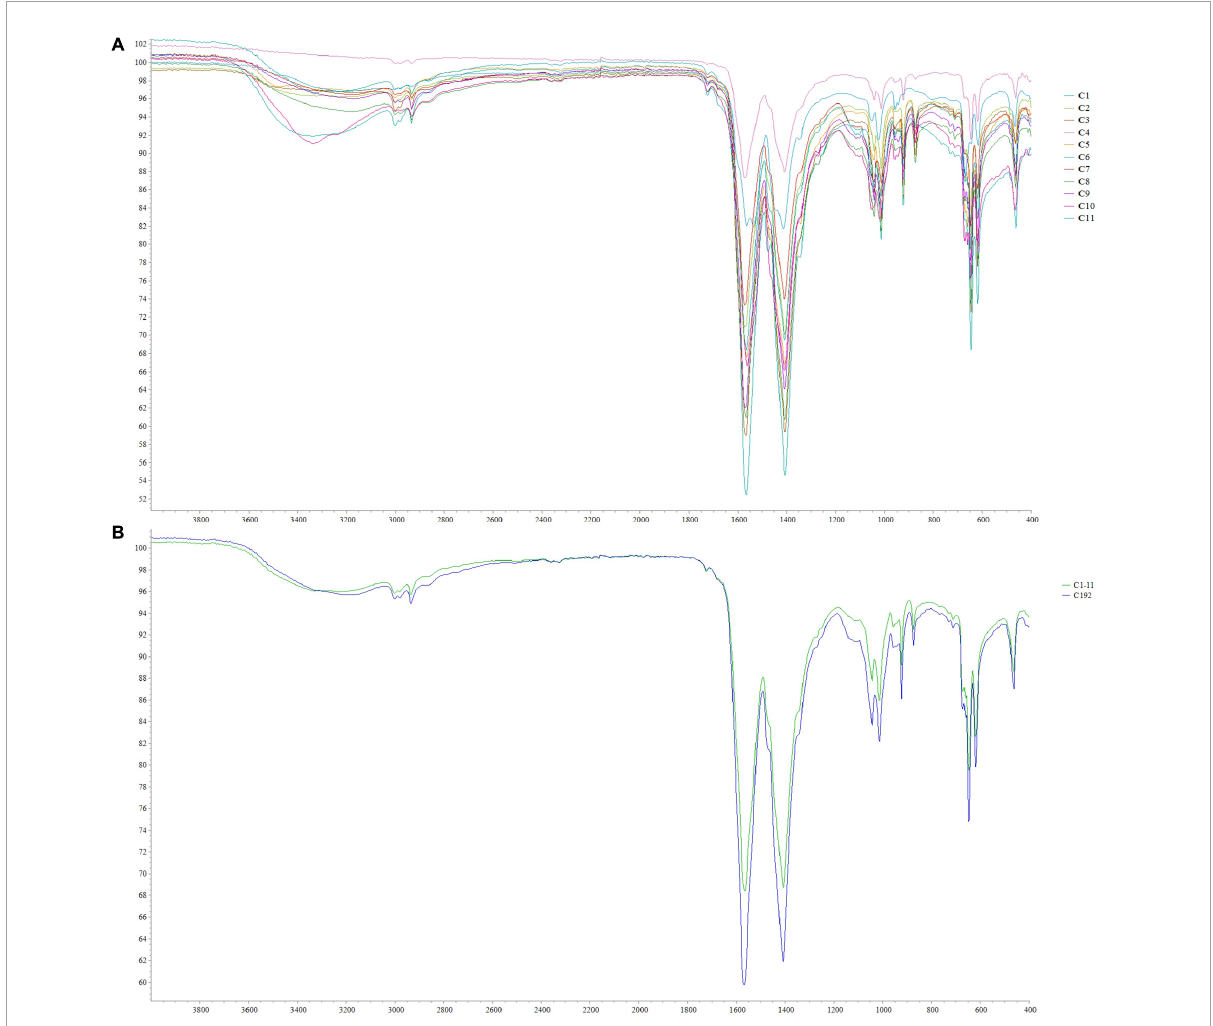
FIGURE6 ATR-FTIR spectra obtained from C1–C11 isolates (A) and comparison between the average spectrum obtained for C1–C11 isolates with that obtained for Synechocystis cf. salina (C192) (B)